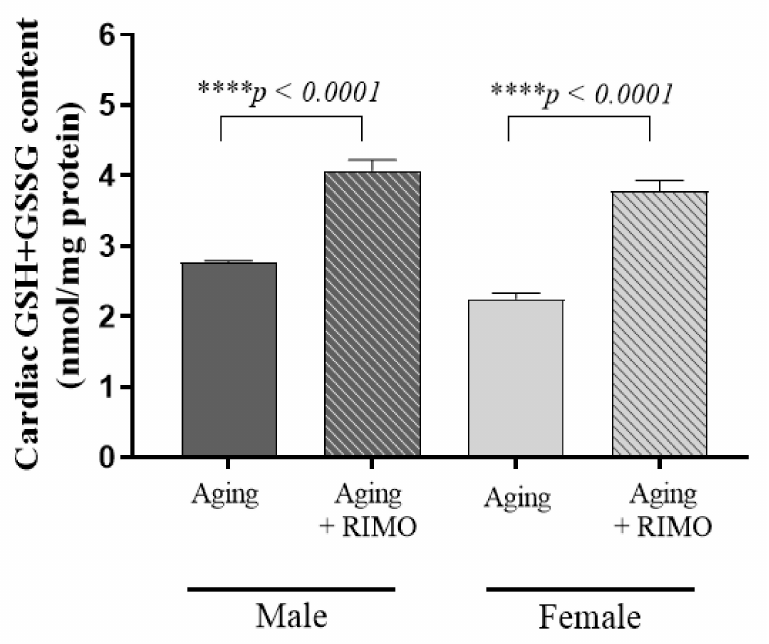
Figure 3. The effects of rimonabant treatment on cardiac GSH+GSSG content in aged animals. (GSH+GSSG; expressed as nmol/mg) Results are shown as means ± S.E.M. n = 5–8. **** p < 0.0001: Statis- tical significance between rimonabant-treated and untreated, sex-matched aging rats. RIMO = rimonabant, GSH+GSSG = total